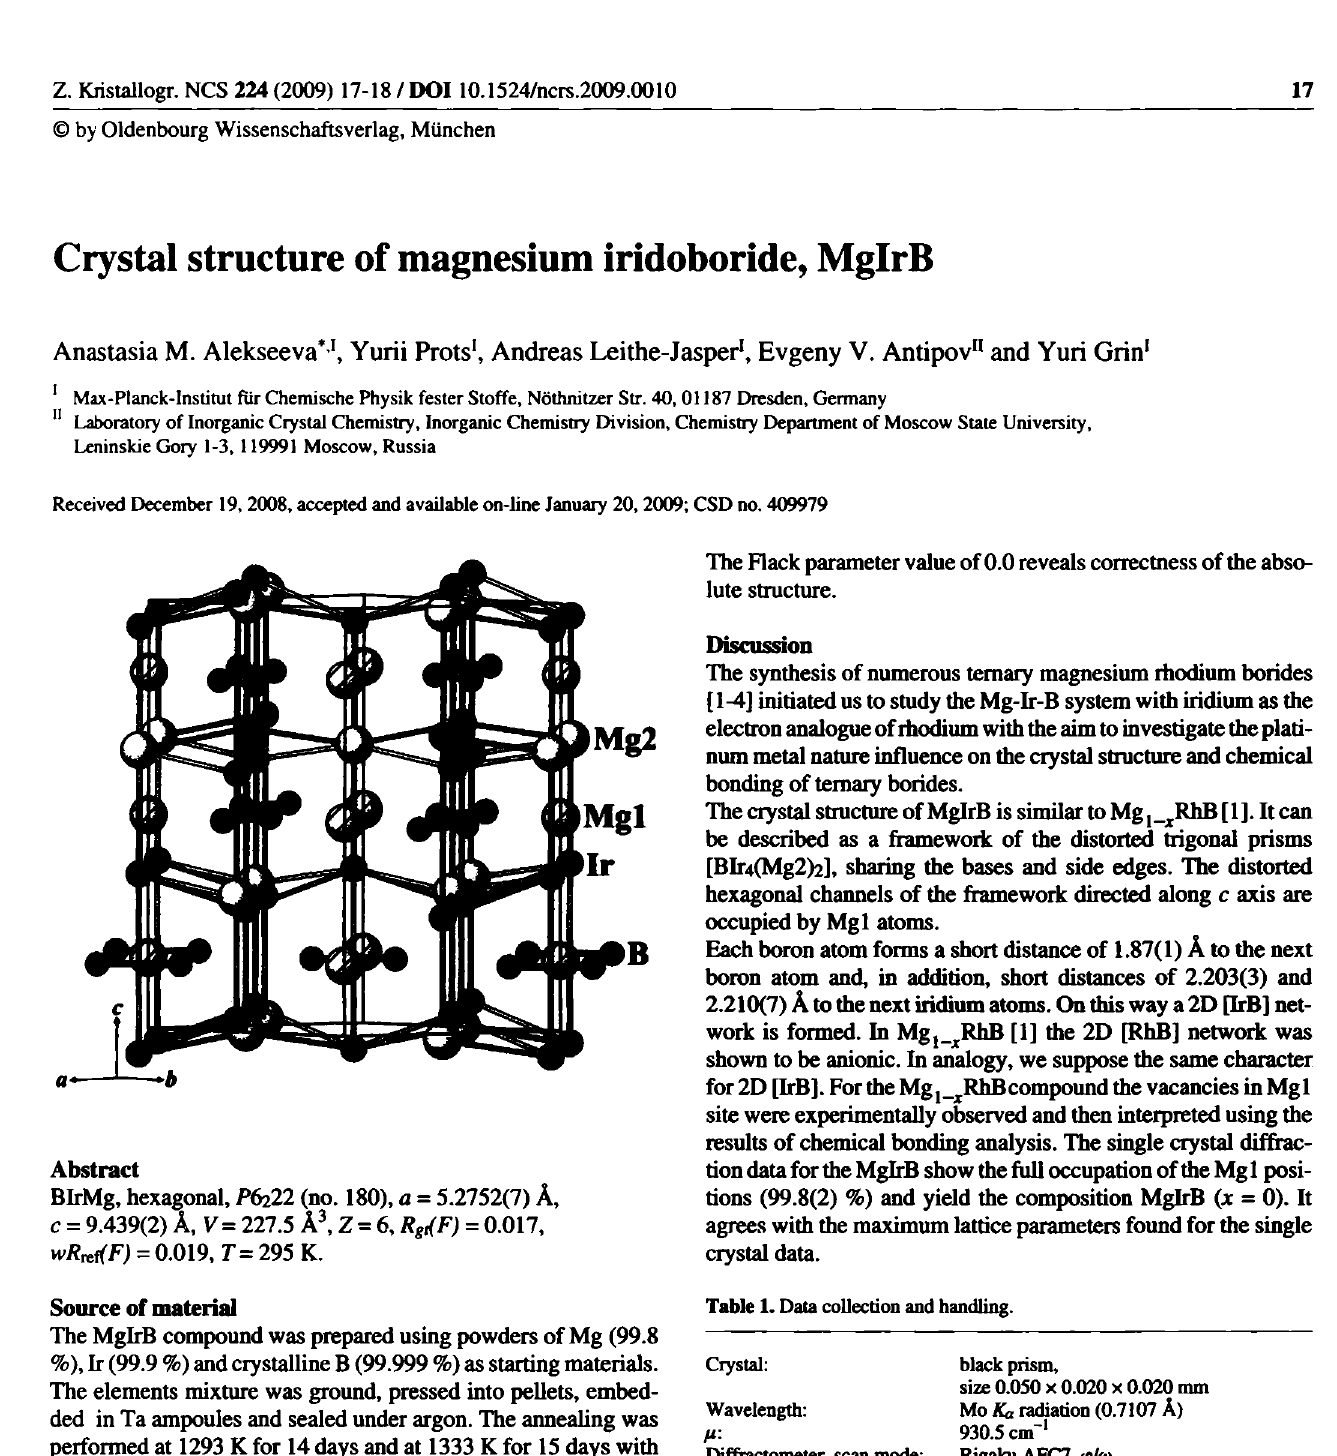
Table 2. Atomic coordinates and displacement parameters (in À 2